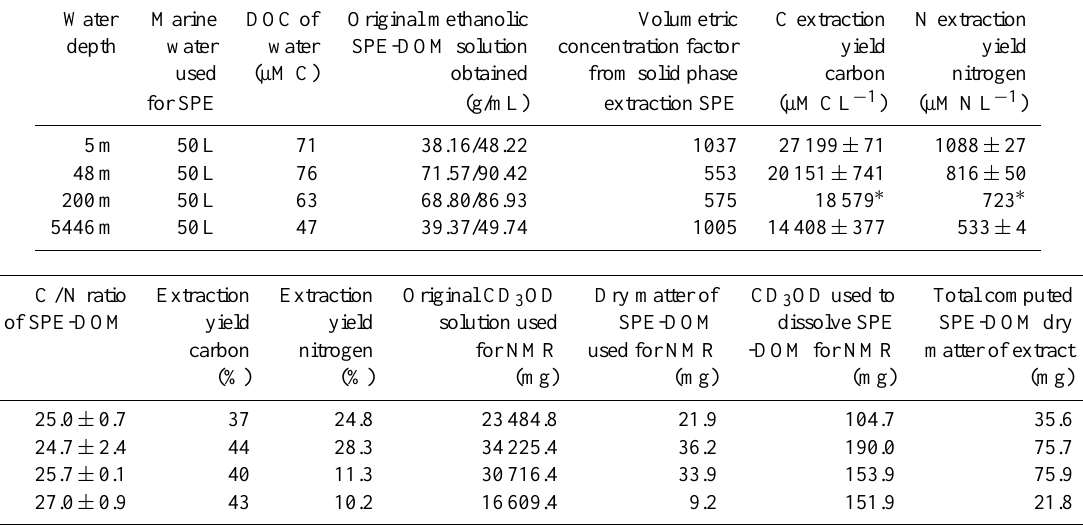
Table 1. Details of marine SPE-DOM isolation and NMR sample preparation by PPL solid phase extraction; volume/weight ratios for methanolic extract were based on the methanol density at 20 ◦ C=0.7915gmL − 1 ; asterisk: only one experiment performed. Water Marine DOC of Original methanolic Volumetric C extraction N extraction depth water water SPE-DOM solution concentration factor yield yield used (µMC) obtained from solid phase carbon nitrogen for SPE (g/mL) extraction